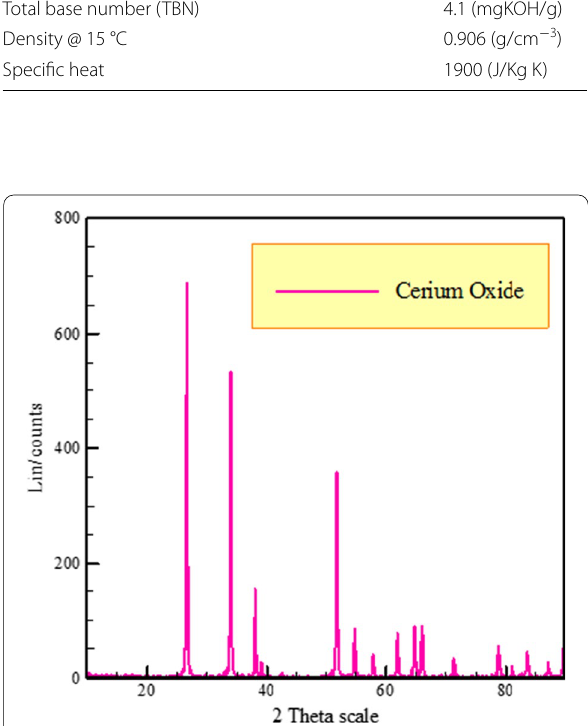
Fig. 1 XRD of cerium oxide nanopowders